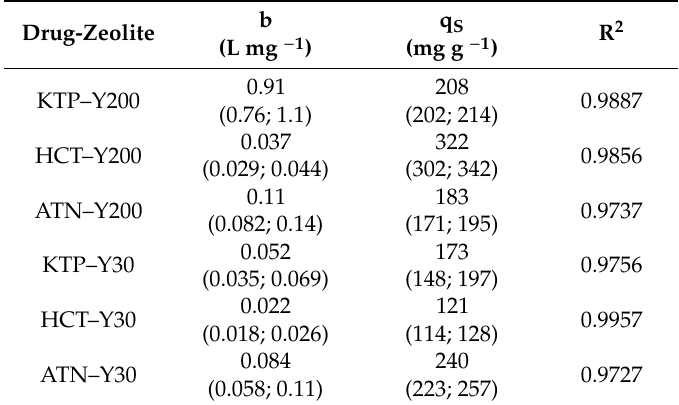
Table 1. Parameters Estimated by Non-Linear Fitting, According to the Langmuir Model, of Three Drugs Adsorption on Y200 and Y30. The Confidence Limits at 95% of Probability of Parameters are Reported in